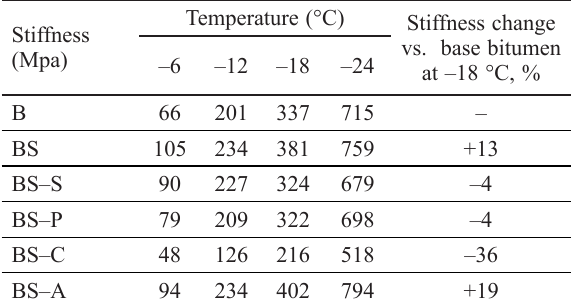
Table 11. Performance grade of base and modified bitumen